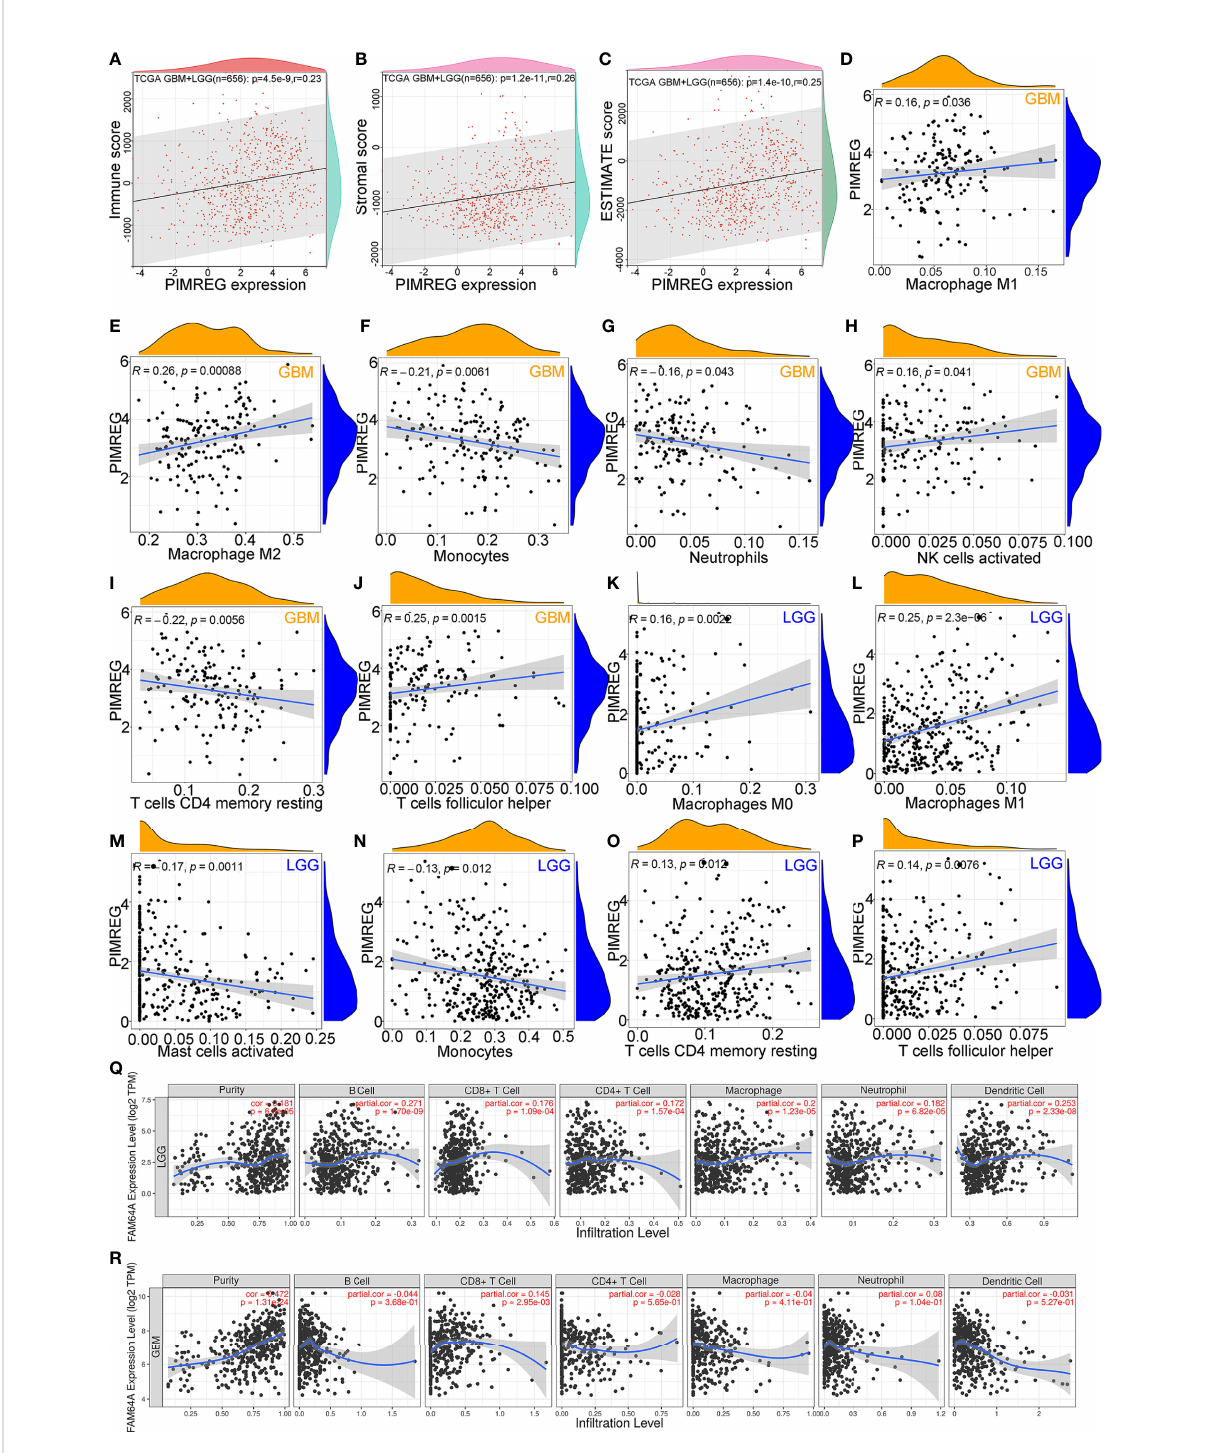
FIGURE 6 Correlation between PIMREG expression and tumor immunity of gliomas. Correlation of PIMREG with immune score (A) , stromal score (B) and ESTIMATE score (C) in LGG+GBM. Correlation of PIMREG with the in fi ltrating levels of M1 macrophages (D) , M2 macrophages (E) , monocytes (F) , neutrophils (G) , activated NK cells (H) , resting memory CD4 T cells (I) , and follicular helper T cells (J) in GBM. Correlation of PIMREG with the in fi ltrating level of M0 macrophages (K) , M1 macrophages (L) , activated mast cells (M) , monocytes (N) , resting memory CD4 T cells (O) , and follicular helper T cells (P) in LGG. Correlation between PIMREG and immune cells in LGG (Q) and GBM (R) in the TIMER